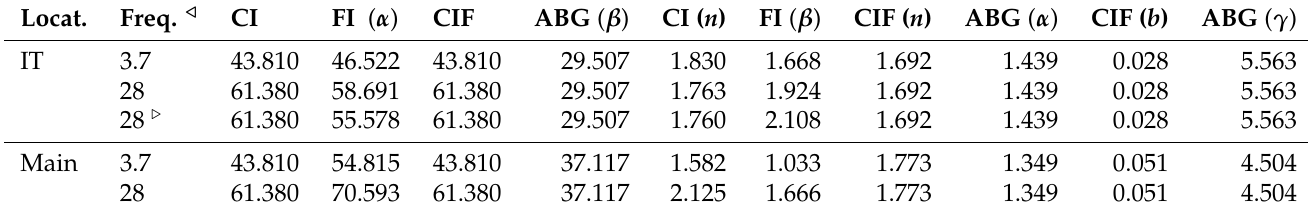
Table 4. Parameters of different propagation